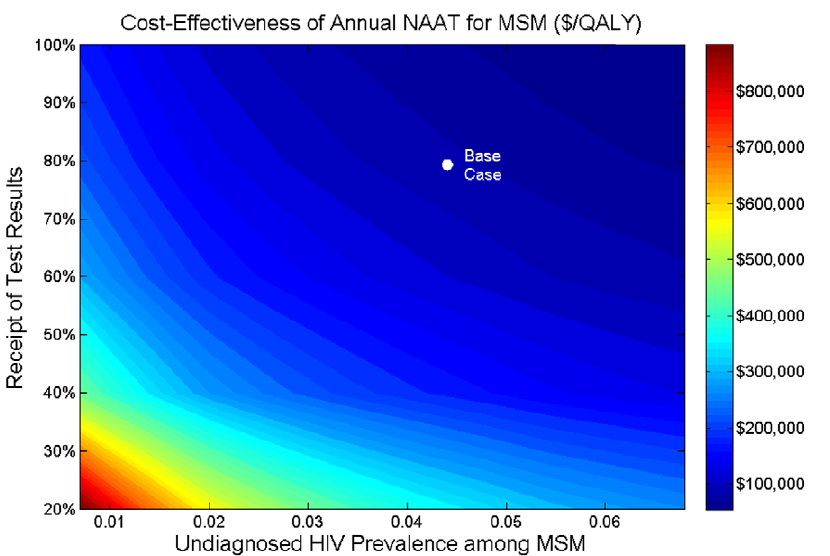
Figure 5. Two-way sensitivity analysis on undiagnosed HIV prevalence among MSM. The cost-effectiveness of annual NAAT testing of MSM, given simultaneous variations in undiagnosed HIV prevalence among MSM and the proportion receiving NAAT test results. Cost-effectiveness is relative to screening with fourth-generationimmunoassay only. MSM = men whohave sex withmen; NAAT = nucleicacid amplificationtest; QALY = quality-adjusted life year.